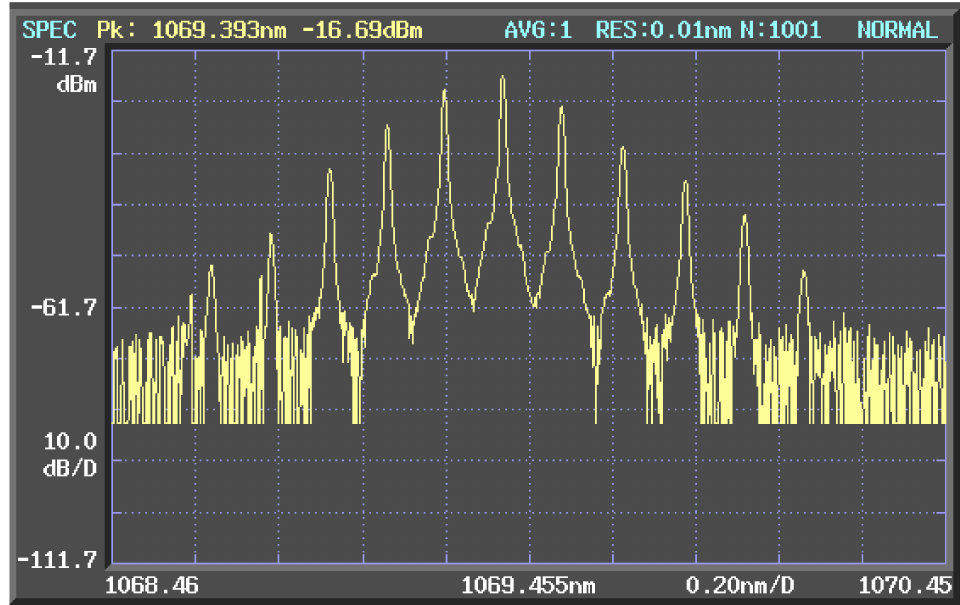
Figure 7. Simultaneous oscillation of 11 wavelengths.